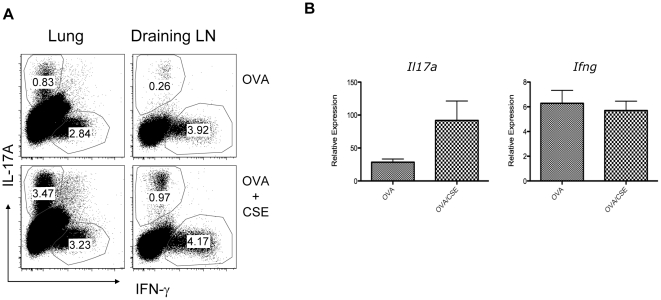
Cigarette smoke extract enhances Th17 differentiation in vivo.(A) OTII mice were given 50 µg OVA in 50 µL HBSS or CSE intratracheally on day 0, day 7 and sacrificed on day 14. Single cell suspensions harvested from lung digest and mediastinal lymph nodes were re-stimulated with PMA and ionomycin in the presence of Golgi-plug for 5h, intracellular cytokines were analyzed by FACS (A). Gene expression in lung tissue was analyzed by real-time RT-PCR (B, n = 5 per group, * denotes p<0.05 compared to OVA alone).